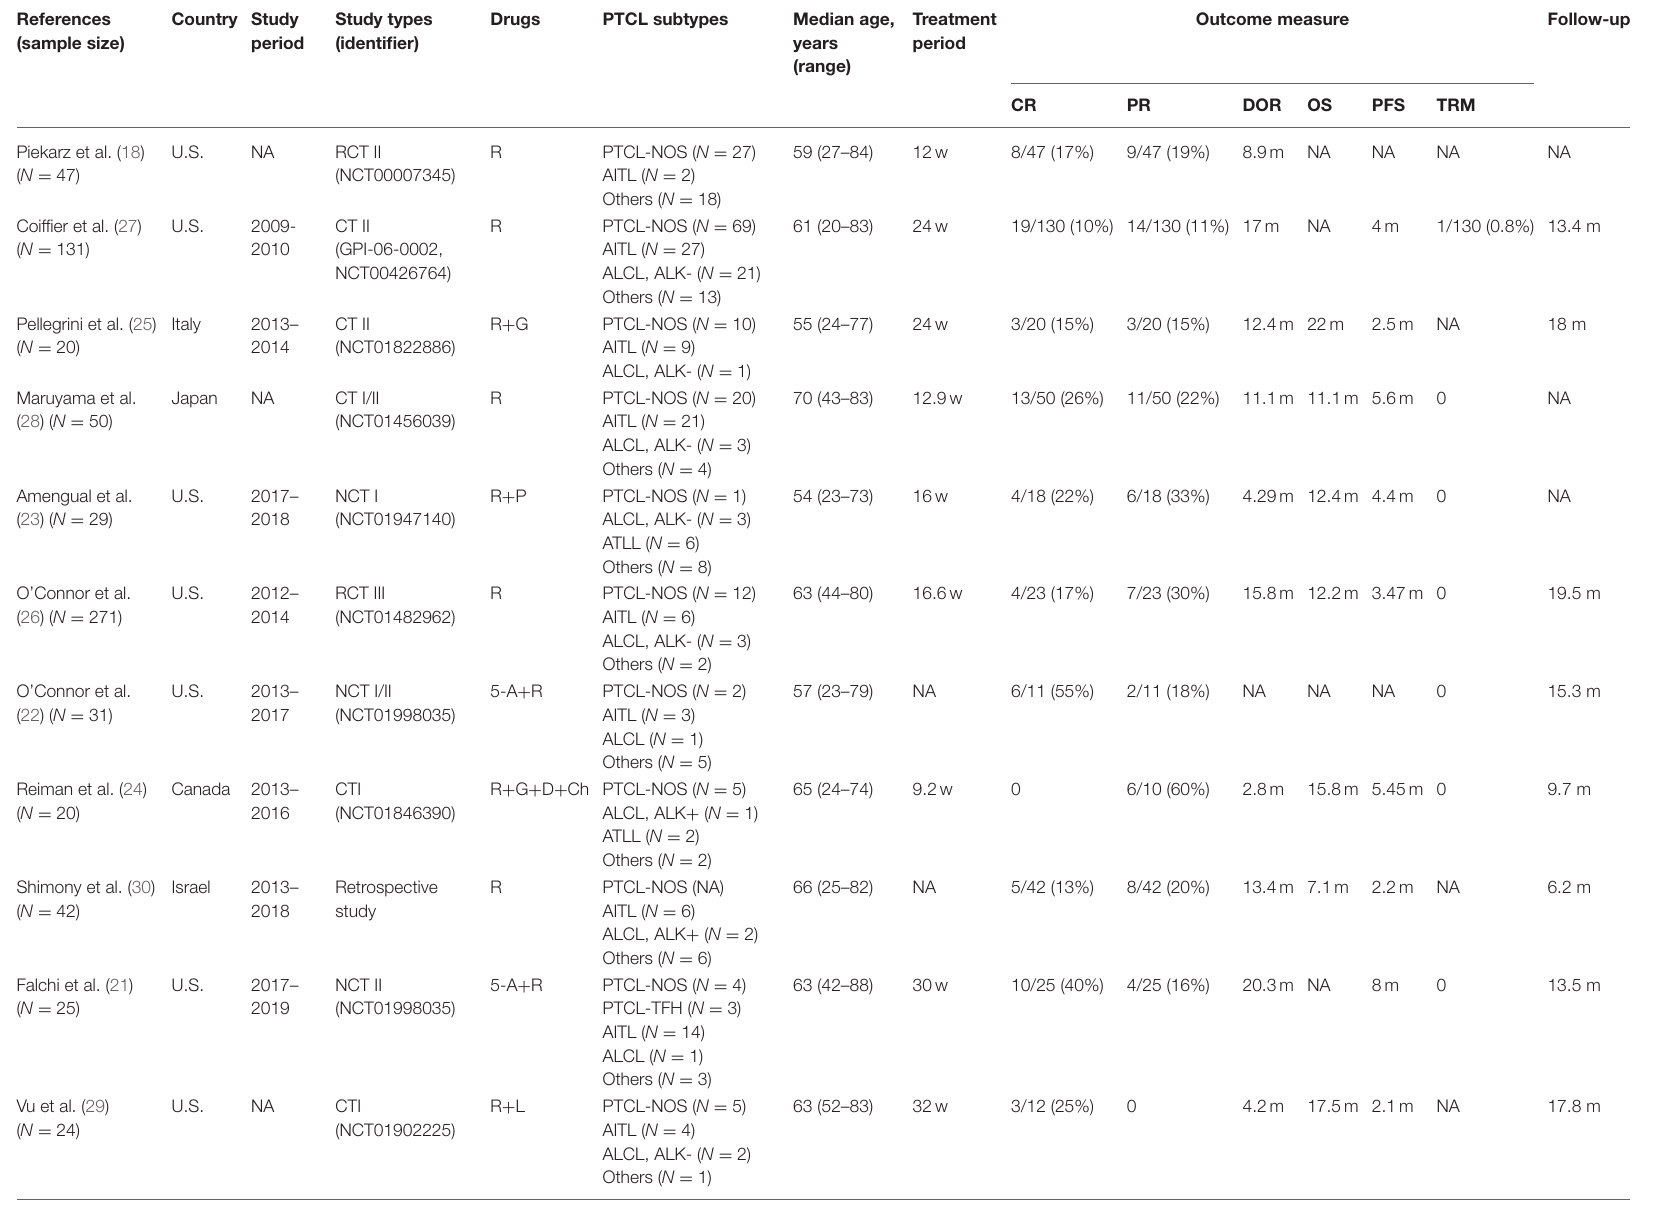
TABLE 1 | Characteristics of the included